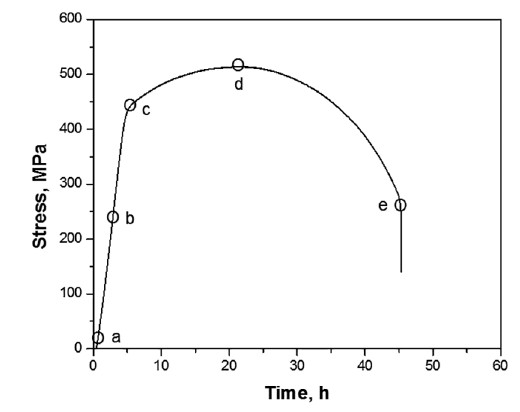
Figure 7. Points of EN measurements, a) at beginning of the test, b) elastic zone, c) yield strength, d) ultimate tensile strength and e) before fracture.